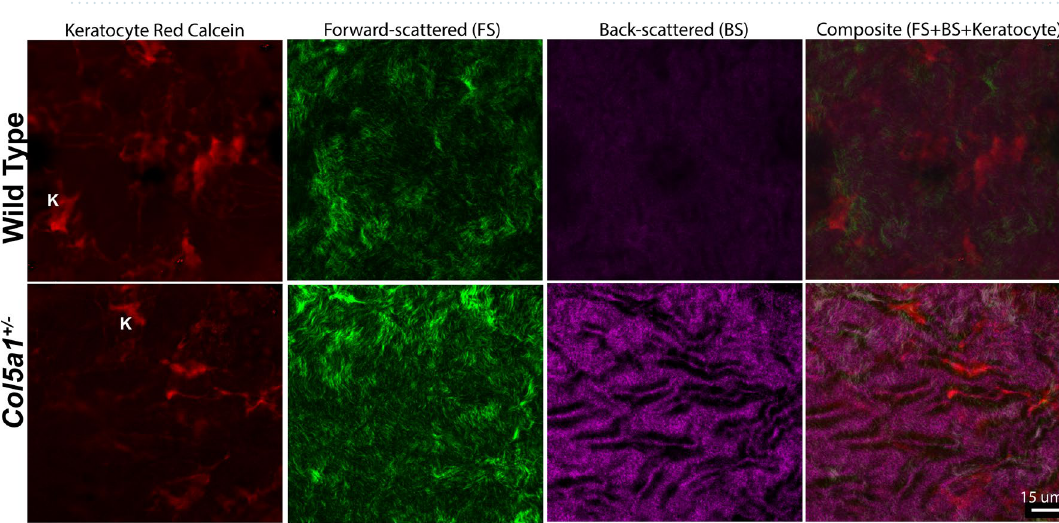
Figure 5. En face SHG images obtained after corneas were dissected from the globe immediately after enucleation and imaged. Keratocytes (K) are shown in red, as the live cell dye Calcein AM penetrates the live keratocyte cell membrane. Note the differences is keratocyte shape in Col5a1 +/− compared to wt and the increase in stromal folds noted in the Col5a1 +/− corneas obtained with back scattered signal. Representative images of Col5a1 +/− (n = 6) and wt (n = 6)